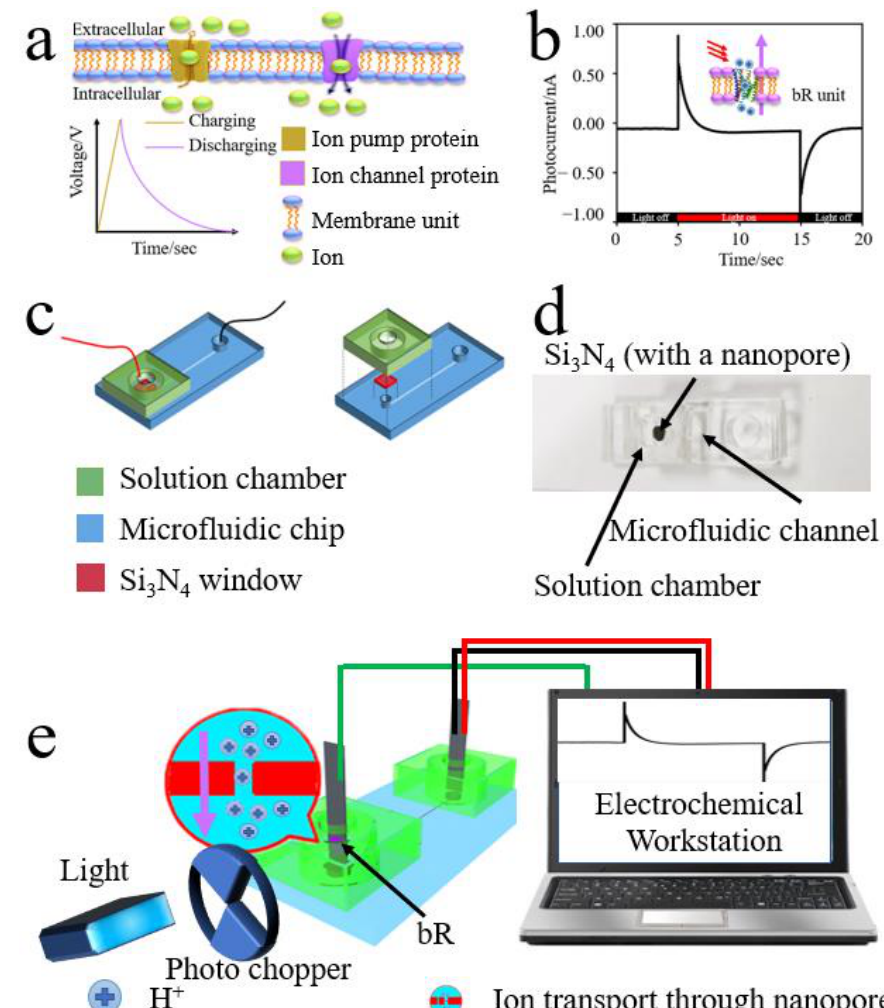
Figure 1. ( a ) The biological model of our device. The cooperation of ion-pump and ion-channel proteins makes the membrane act as a capacitor. ( b ) Photocurrent–time image of bR. ( c ) As-designed microfluidic chip. ( d ) Optical image of the device. ( e ) Schematic diagram of the complete test system.